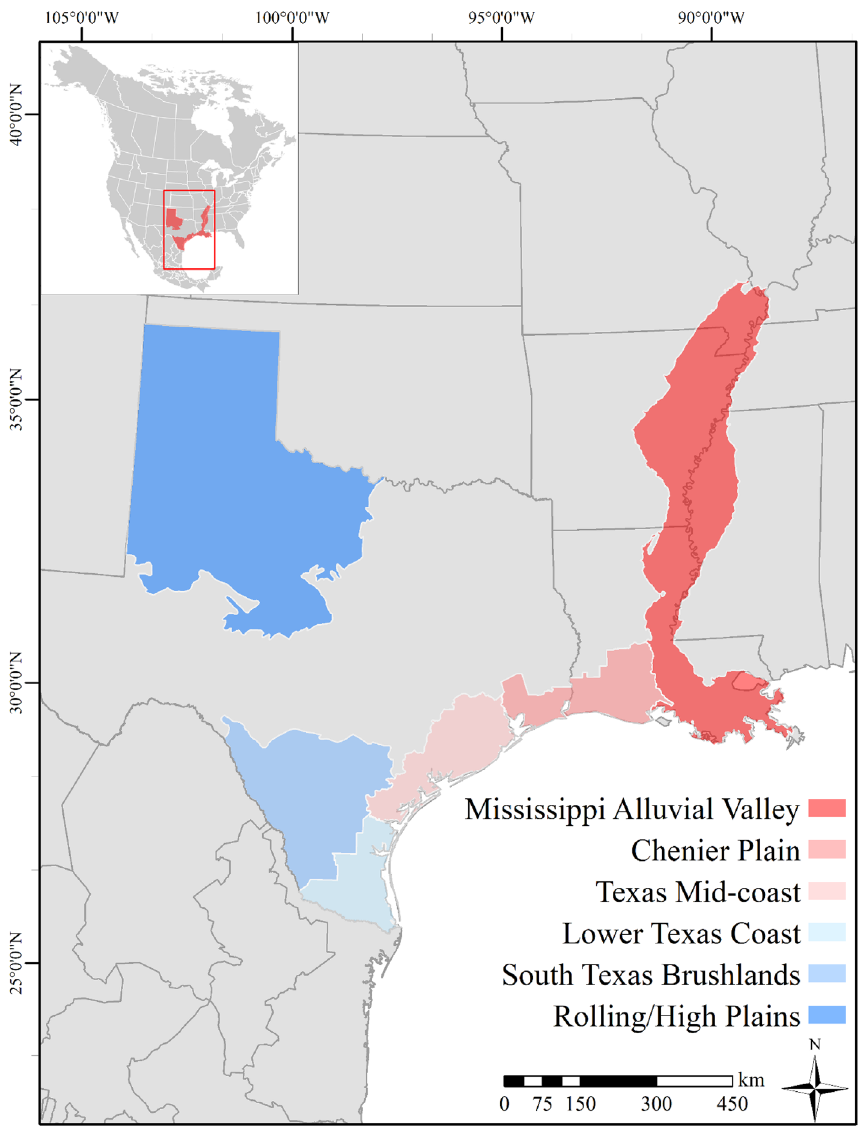
Figure 1. Primary wintering regions of the Midcontinent population of greater white-fronted goose ( Anser albifrons frontalis ) in North America (excluding regions in Mexico). Transmitters were deployed during winters 2016–2018 in the Chenier Plain (Louisiana), Lower Texas Coast, and Rolling/High Plains regions. Geese that made winter movements outside of these defined regions were classified as ‘Other’ regions. Map created using Esri ArcMap (version 10.3.1; www. esri.